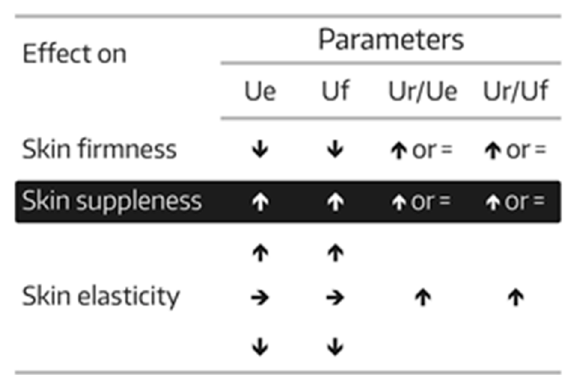
Figure 1. Definitions of skin firmness, skin suppleness and skin elasticity applied in the study. Ue = immediate distensibility, Uf = total skin distensibility, Ur = immediate recovery, Ur/Ue = net elasticity, Ur/Uf = ratio of elastic recovery to distensibility.